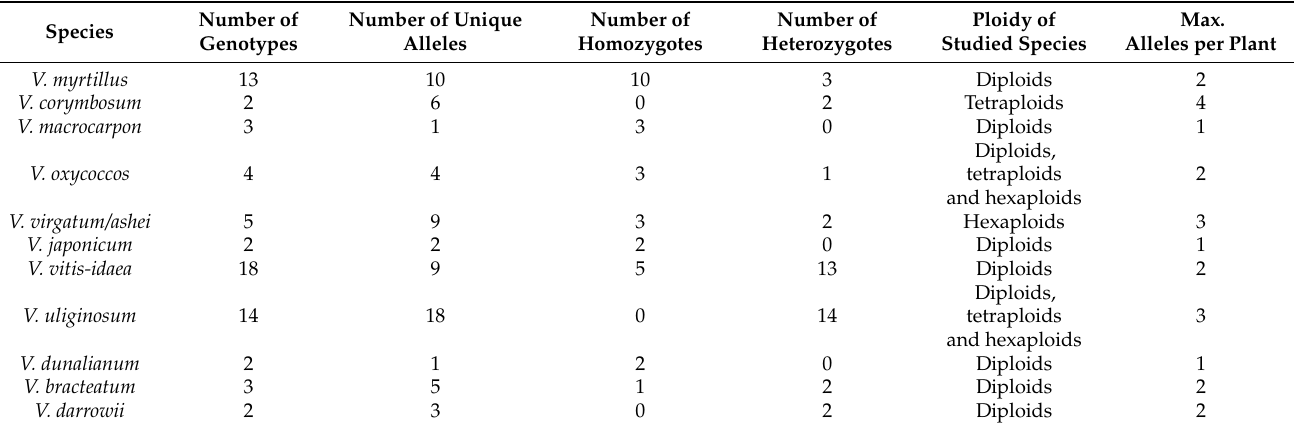
Table 2. Studied genotypes of Vaccinium and their allelic status.